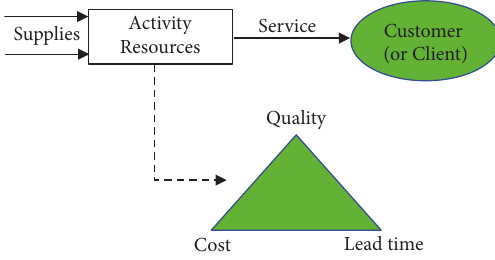
Figure 2: Current economic performance system.